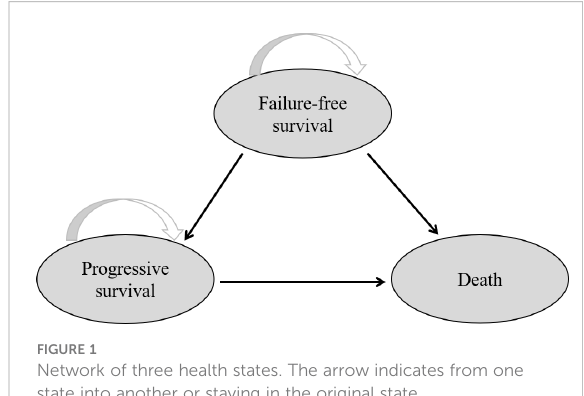
FIGURE 1 Network of three health states. The arrow indicates from one state into another or staying in the original